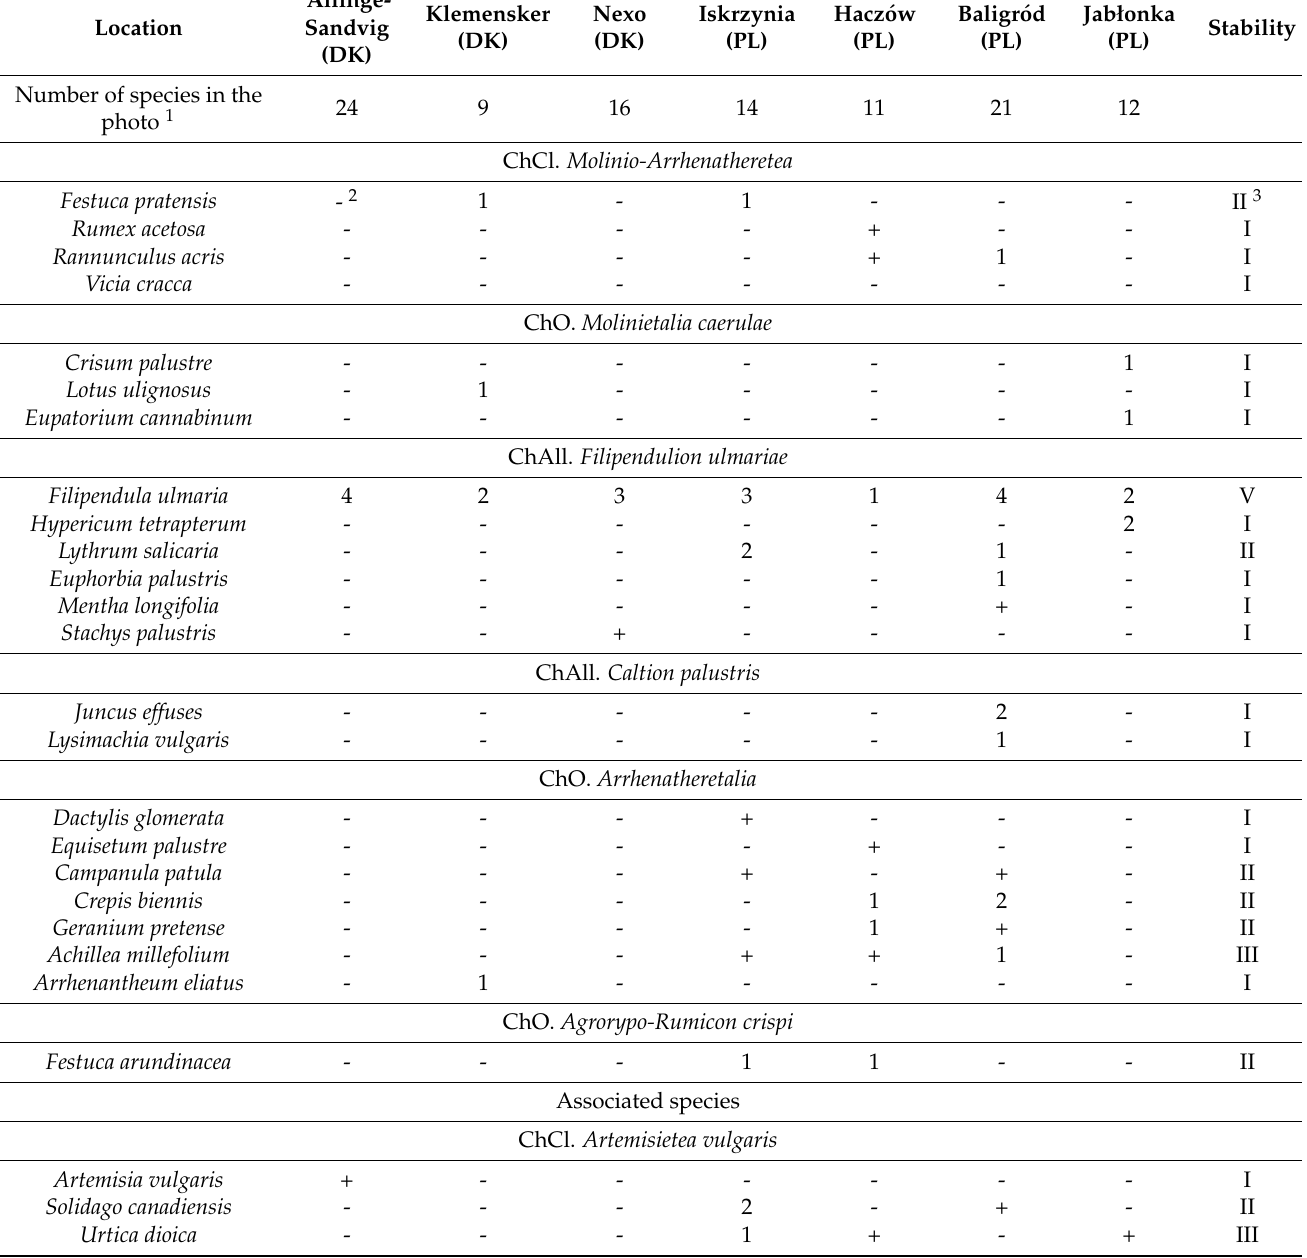
Table 1. Phytosociological analysis of meadowsweet